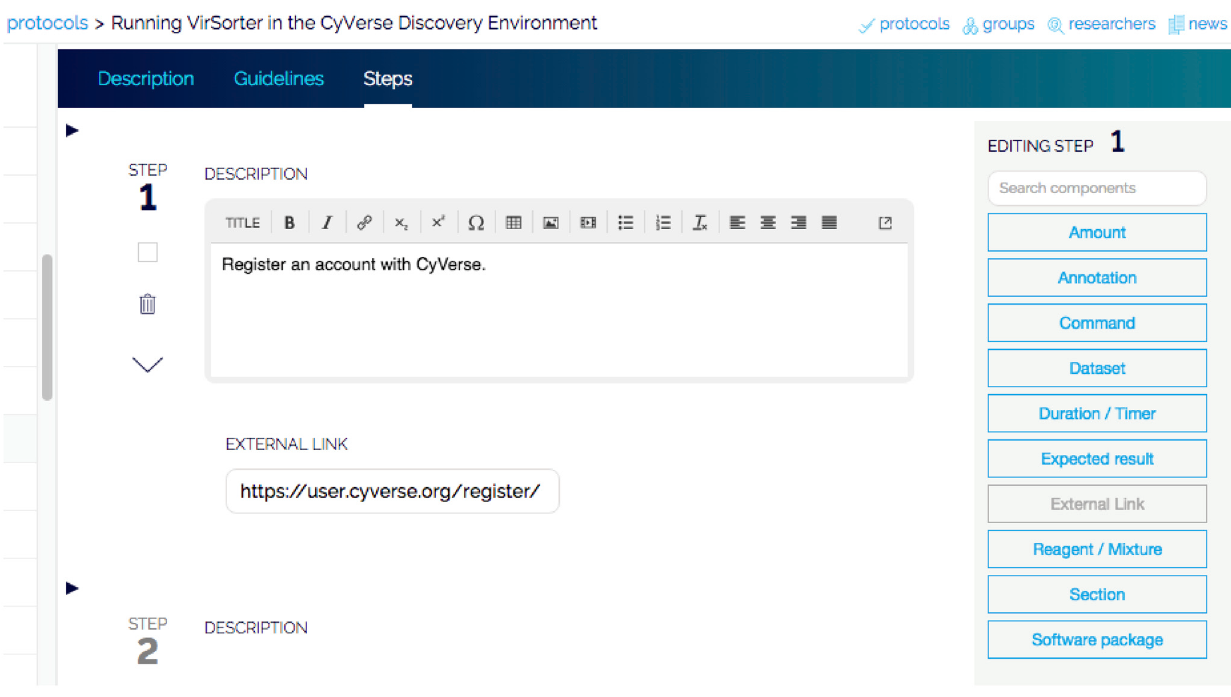
Figure 1. Entering a protocol in protocols.io. Protocols are entered by providing a broad description, information about authors, any prior materials or background required, and detailed step-by-step methods to implement the protocol. Protocols can remain private to an individual or group, or released to the